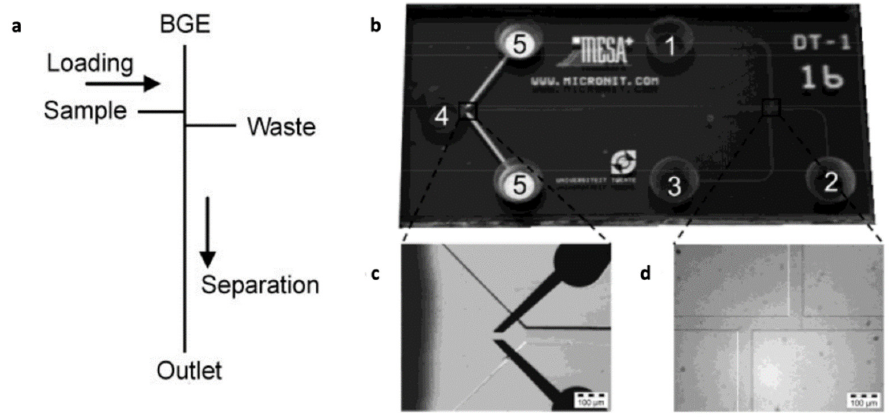
Figure 9. ( a ) Schematic representation of the channel layout of the CE chip with double-T injection geometry (modified with permission from Vrouwe et al., Electrophoresis , 2005 [77]). ( b ) Photograph of the microchip: 1, sample compartment; 2, BGE compartment; 3, waste compartment; 4, outlet compartment; 5, detection electrodes. Close-ups of the end of the channel with ( c ) the conductivity detection electrodes and ( d ) double-T injector (modified with permission from Vrouwe et al., Elec- trophoresis , 2004